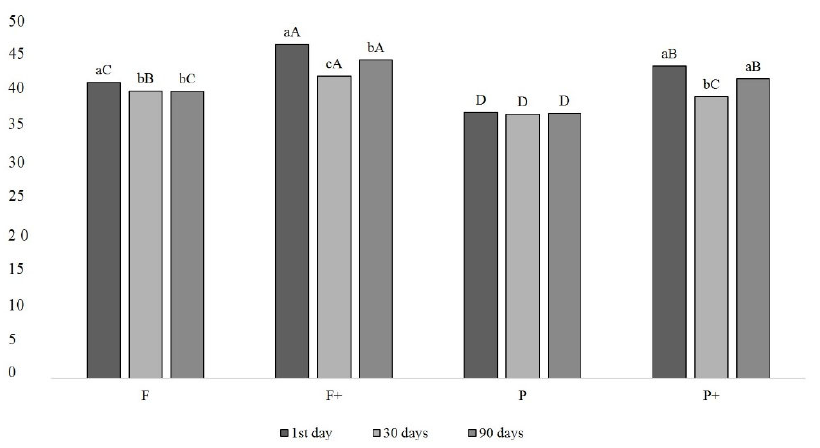
Figure 4. Moisture content (mc%) of fresh and pasteurized samples during the storage period. Letters show differences by Tukey’s multiple range test (lowercase among the same sample during the storage period and uppercase among the different samples).